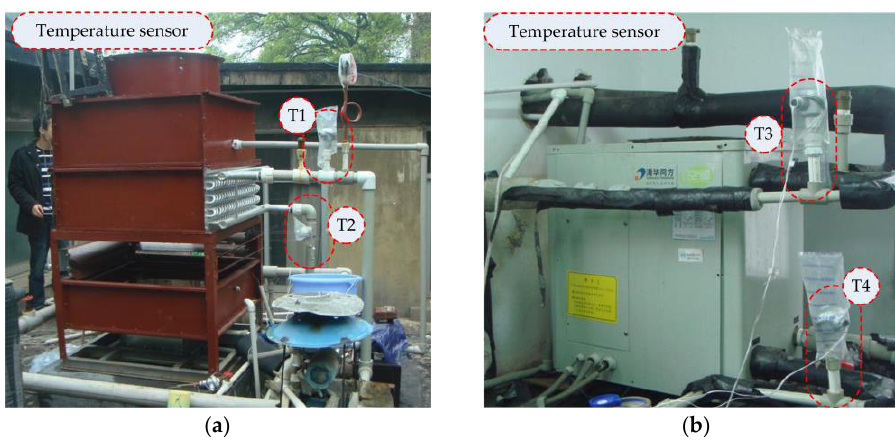
Figure 3. Photographs of: ( a ) closed wet cooling tower; and ( b ) water source heat pump unit. T1, T2, T3 and T4 indicate the condense water temperatures sensors at the inlet and outlet of cooling tower, inlet and outlet chilled water temperatures sensors, respectively.